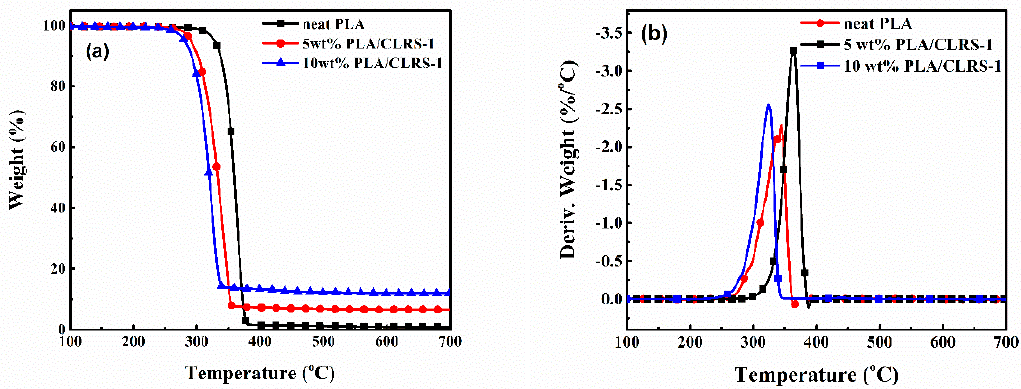
Figure 8. The thermogravimetric curves ( a ) and differential thermogravimetric curves ( b ) of 3D printed neat PLA and PLA/CLRS-1 composite specimens. Table 5. The thermal properties of 3D printed neat PLA and PLA/CLRS-1 composite specimens.